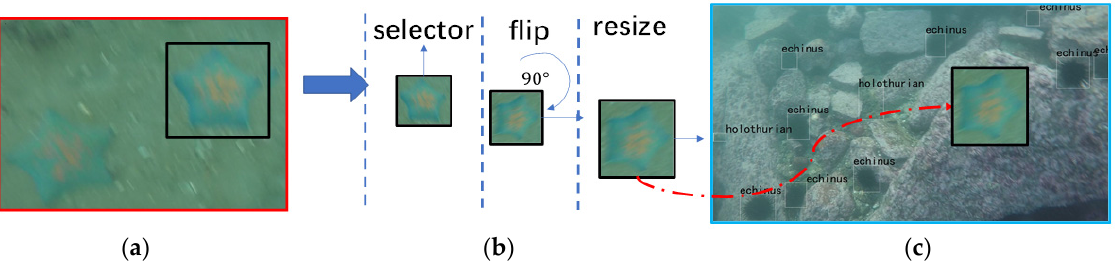
Figure 5. The process of the non-overlapping filling of scarce samples: ( a ) Image with scarce target; ( b ) label augmentation pipeline; and ( c ) input image with a scarce target. The red box represents the image selected from the scarce target set. The black boxes represent the scarce target selected from the area surrounded by the red box.